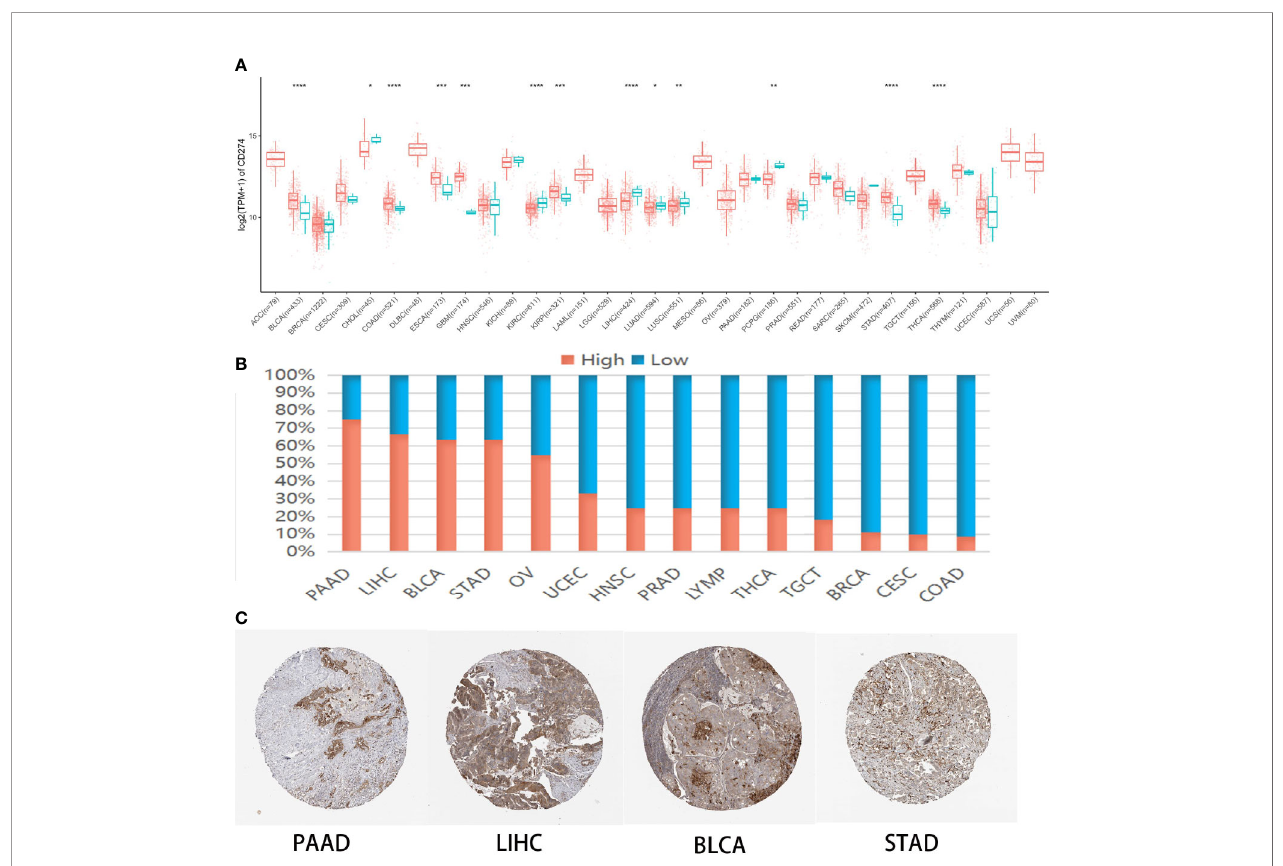
FIGURE 1 | CMTM6 expression in human pan-cancer. (A) Differential CMTM6 mRNA expression between tumor and normal tissues in The Cancer Genome Atlas (TCGA) cohort. Red color represents cancer samples and blue color represents normal samples (B) . CMTM6 protein expression across 20 cancer types in Human Protein Atlas (HPA). (C) Representative immunohistochemical staining of CMTM6 in HPA. *p < 0.05; **p < 0.01, ***p < 0.001, ****p <